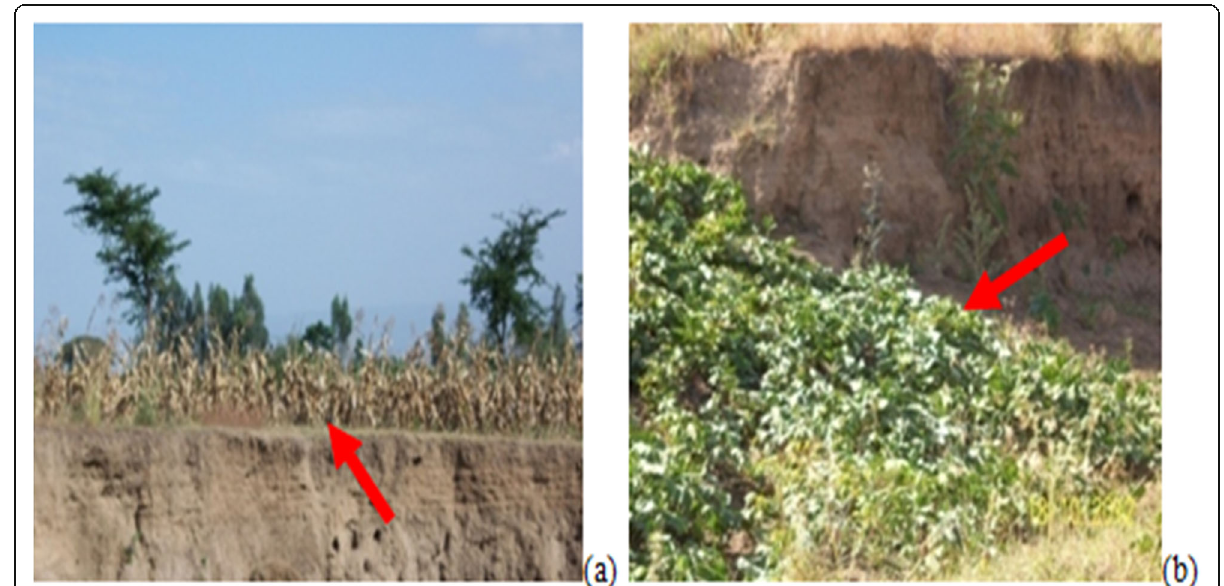
Fig. 2 Gully bank and gully bottom cultivation from left to